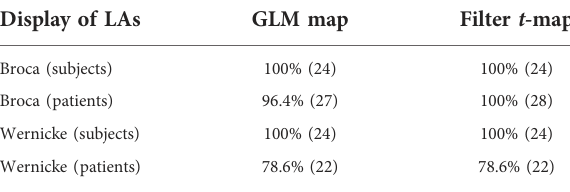
TABLE 2 This table describes how many activation maps displayed language activations (of Broca ’ s and Wernicke ’ s areas) in both maps. Display of